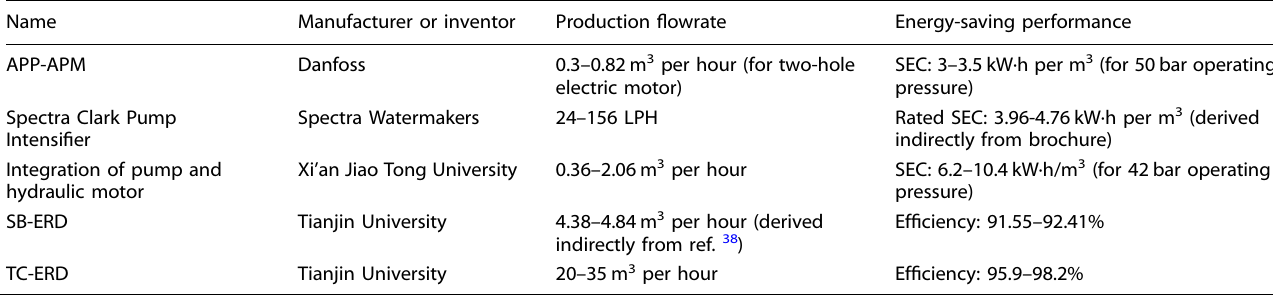
Table 2. The characters of several kinds of small-scale